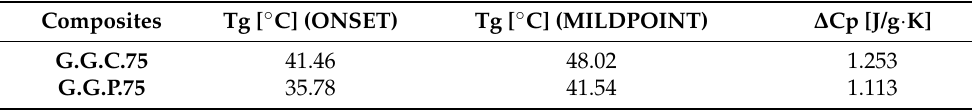
Table 6. Thermal properties of samples containing fillers with flame-retardant properties.